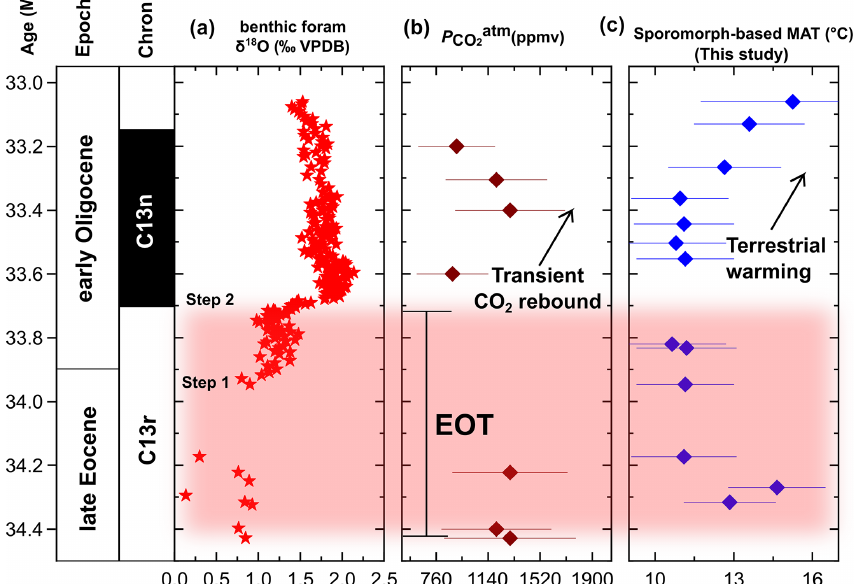
Figure 5. Comparison of the sporomorph-based MAT in the Tasmanian Gateway region across the EOT and earliest Oligocene to regional and global marine EOT and earliest Oligocene records. (a) Marine benthic foraminiferal calcite δ 18 O record from ODP Site 1218 (Pälike et al., 2006). (b) Marine δ 11 B-derived atmospheric p CO 2 record (Anagnostou et al., 2016). (c) Terrestrial temperature change across the EOT and earliest Oligocene based on our sporomorph-based MATs from ODP Site